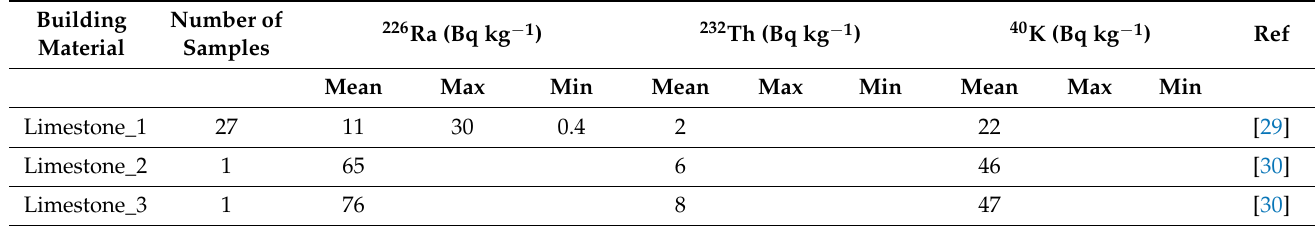
Table 3. Radioactivity content in limestones, ISTISAN report [12].